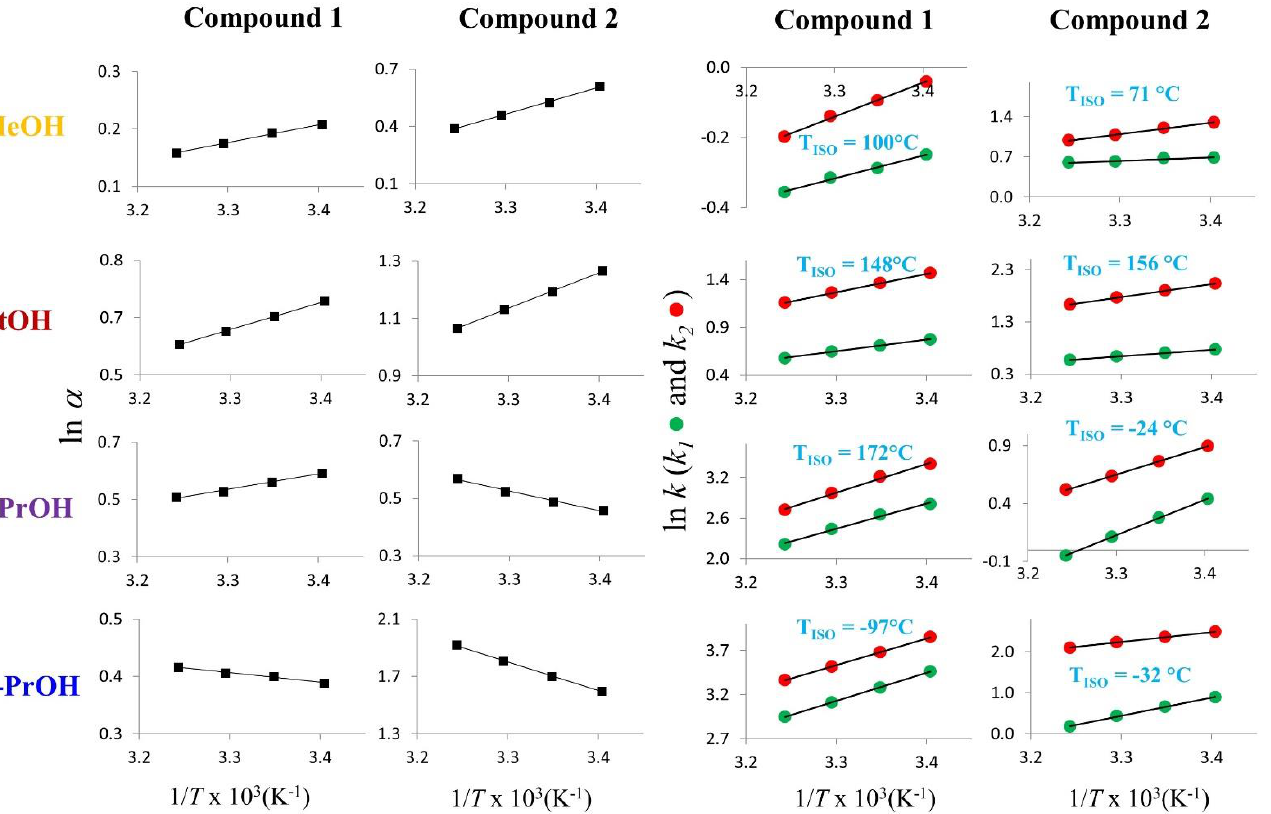
Figure 4. Plots of ln k vs. 1/ T × 10 3 and ln α vs. 1/ T × 10 3 for 1 and 2 . Chromatographic conditions: column, Chiralpak AD-3 (100 mm × 4.6 mm, 3 µ m); flow rate, 1 mL/min; temperature, 25 ◦